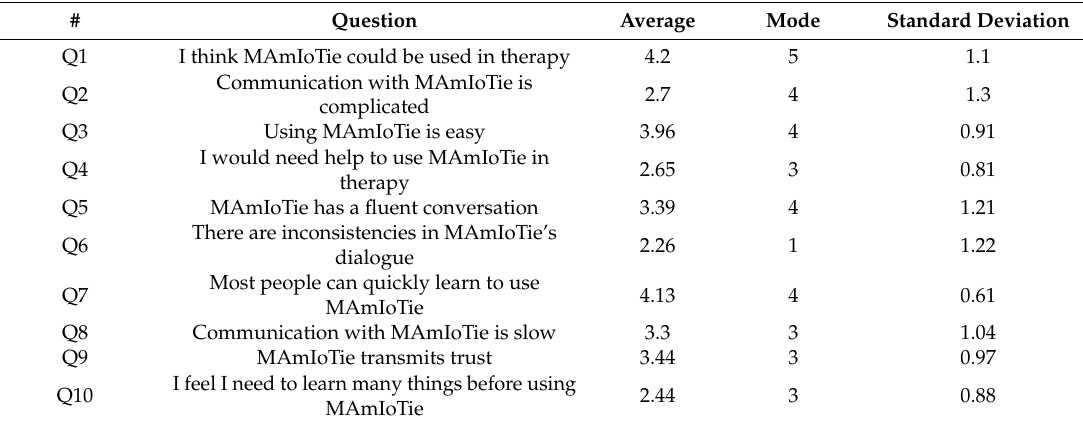
Table 7. Questions, overall average score for each question, as well as mode and standard